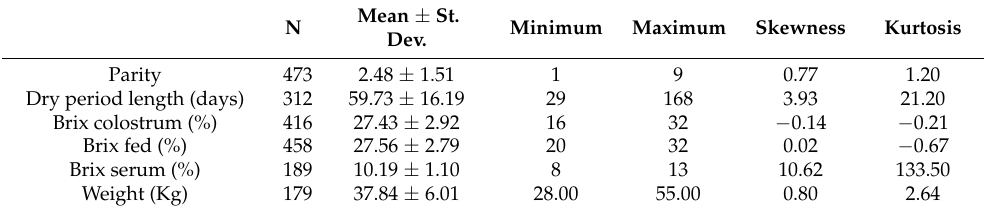
Table 1. Distribution of dam parity, dry period length, Brix% of dam colostrum and colostrum fed, serum Brix% of female Holstein calves, and weight at birth.